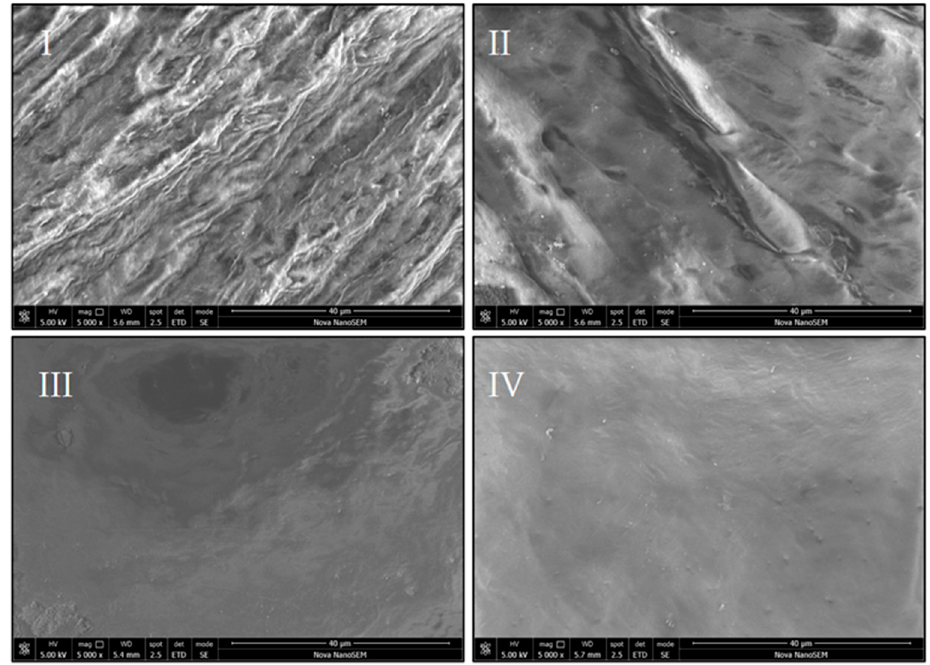
Figure 7. SEM images for DM obtained from the tested protocols.